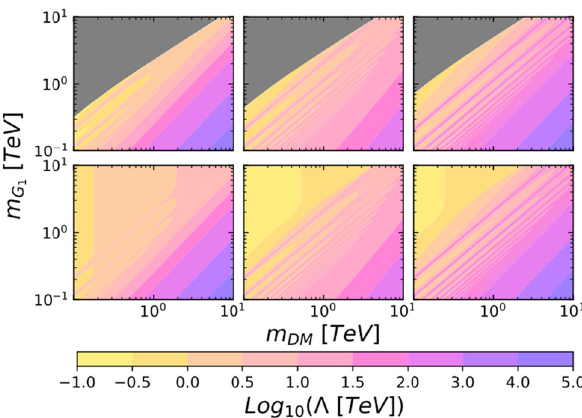
Fig. 3 From left to right we present the values of (cid:3) for which the observed DM relic abundance is obtained in the ( m DM , m G scalar, fermion and vector boson DM particles. Upper panels: the extra- Fig. 2 Several examples for the total thermally-averagedcross-section dimension length is unstabilized; Lower panel: the extra-dimension = 1 TeV as a function of the DM mass m DM . Upper left panel: m G length is stabilized using the Goldberger–Wise mechanism, with a 1 = 1 TeV and (cid:3) = 100 and (cid:3) = 500 TeV; Upper right panel: m G radion mass m r = 100 GeV. The required (cid:3) ranges from 10 − 1 1 = 2 TeV and (cid:3) = 10 TeV; Lower left TeV; Lower left panel: m G 1 = 2 TeV and (cid:3) = 3 TeV. The red dotted line represent panel: m G 1 the (cid:4) σ v (cid:5) th ≡ 2 . 2 · 10 − 26 cm 3 / s . The blue dashed, orange dot-dashed and solid green lines represent the scalar, fermion and vector boson DM cases, respectively. In all plots the radion mass has been kept fixed to m r = 500 GeV